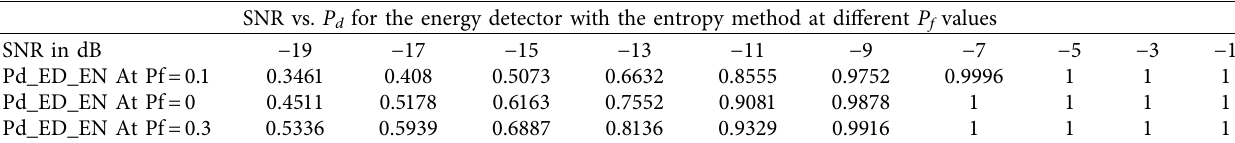
Figure 10: SNR vs. P d at various P f values. Table 6: SNR vs. P d for the energy detector with the entropy method at different P f values. SNR vs. P d for the energy detector with the entropy method at different P f